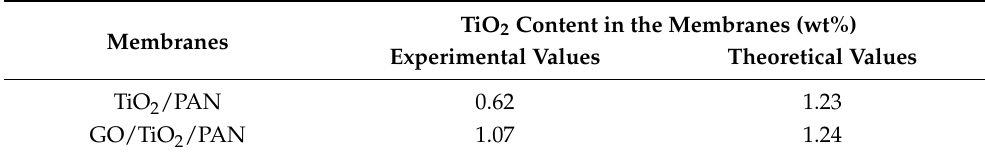
Table 2. TiO 2 content in the TiO 2 /PAN and GO/TiO 2 /PAN membranes. TiO 2 Content in the Membranes (wt%) Membranes Experimental Values Theoretical